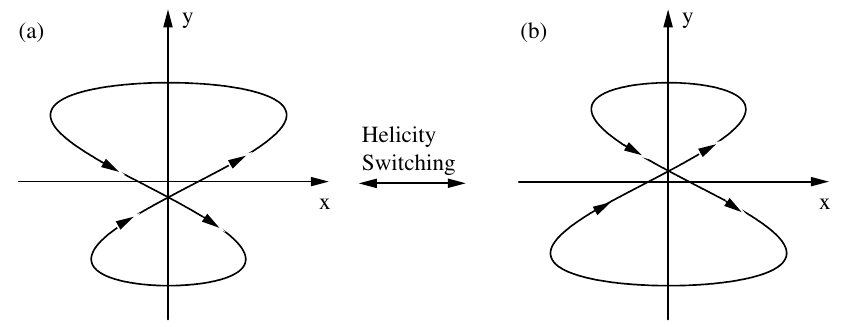
FIG. 1. The electron orbits of an asymmetric figure-8 undulator projected onto the transverse plane. In the asymmetric figure-8 undulator, the helicity switching means to change the trajectory (a) and